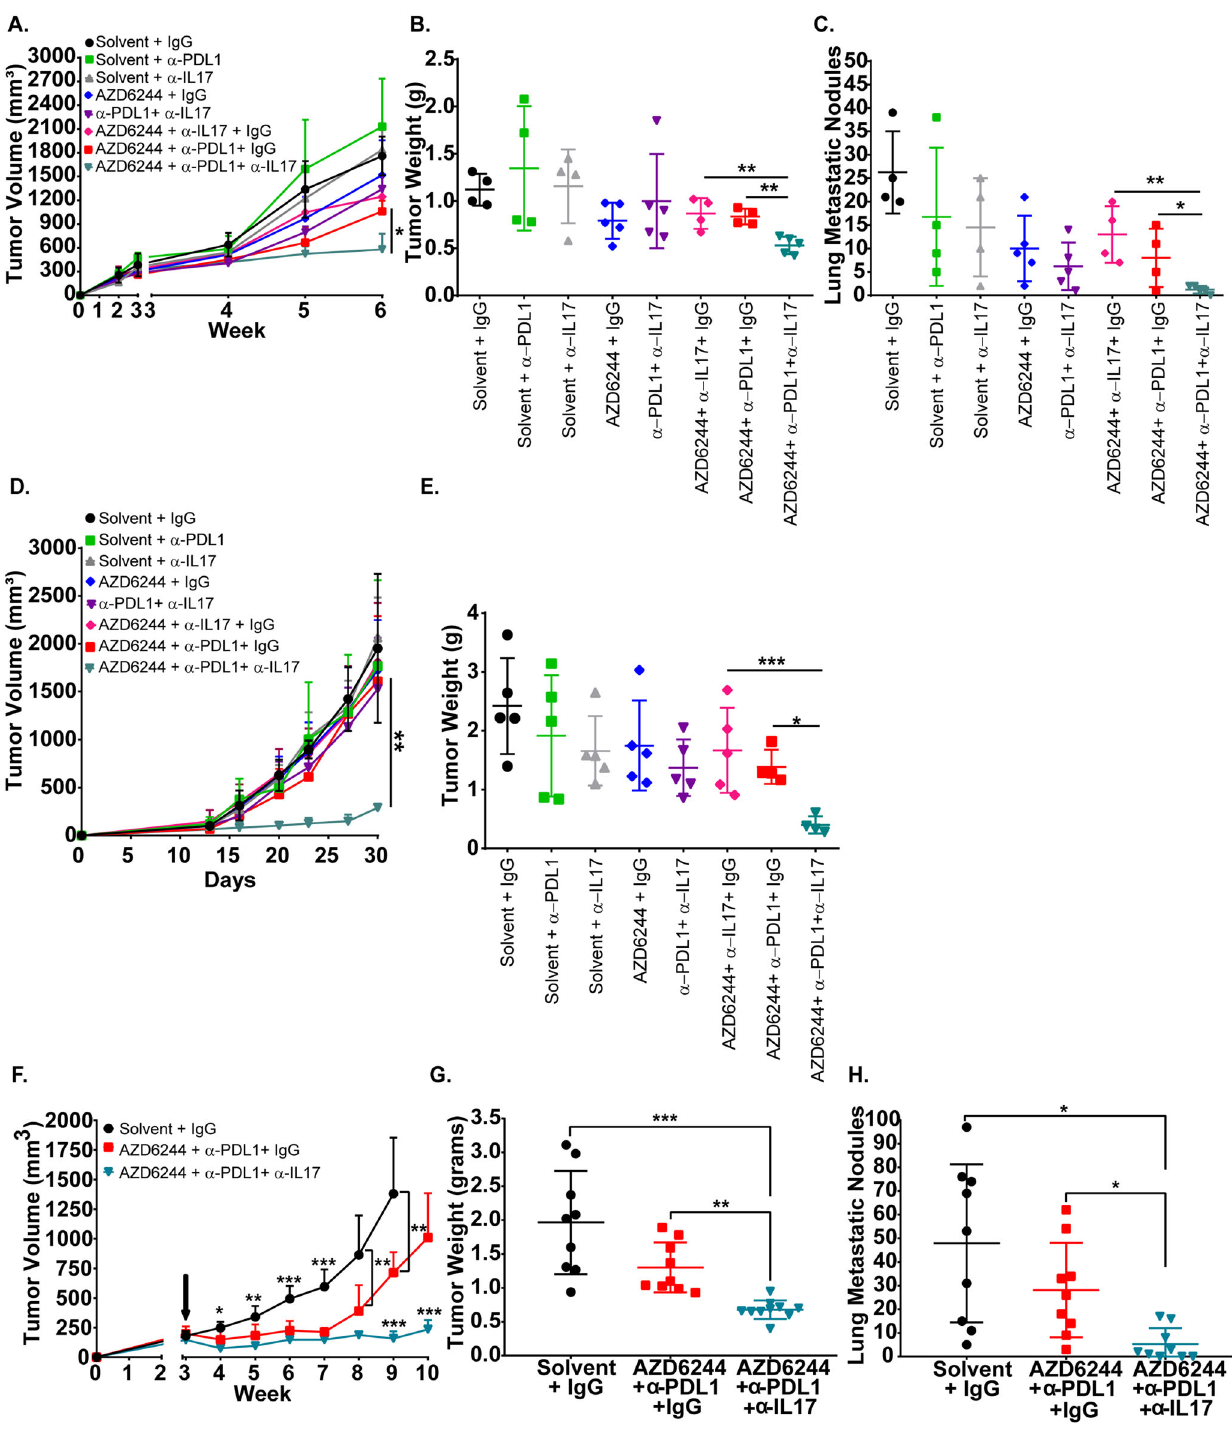
Our identi fi cation that the Th17-associated cytokine IL-17 pro- motes resistance to anti-PD-L1 alone or in combination with MEK inhibition validates a novel triple combinatorial therapeutic strategy for lung cancer patients, consistent with observations that IL-17 is involved in tumor progression 21,25 . Moreover, the increase in cancer cell IL-6 expression from combination therapy as well as the role of Th17 in autoimmunity suggests that IL-17 blockade could potentially ameliorate the observed clinical adverse events owing to